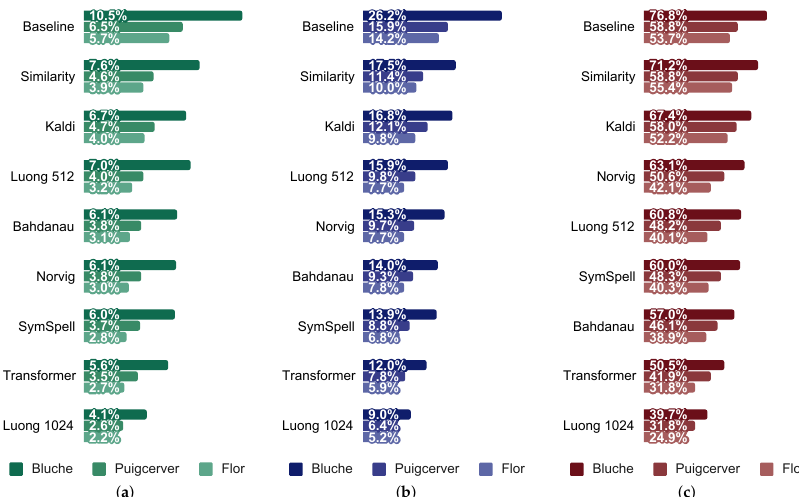
Figure 12. Error rates in the Bentham dataset (lower is better), ( a ) Character Error Rate (CER); ( b ) Word Error Rate (WER); ( c ) Sequence Error Rate (SER).